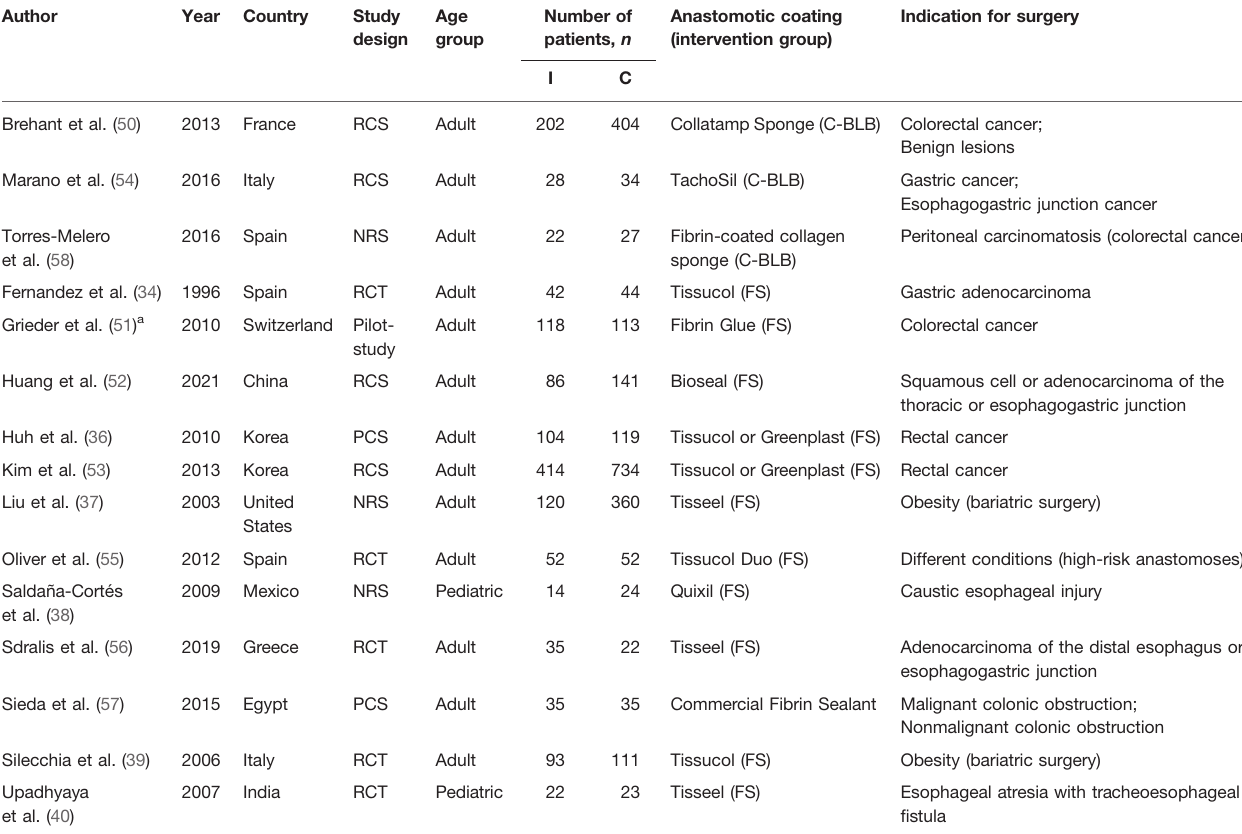
TABLE 1 | Study and patient